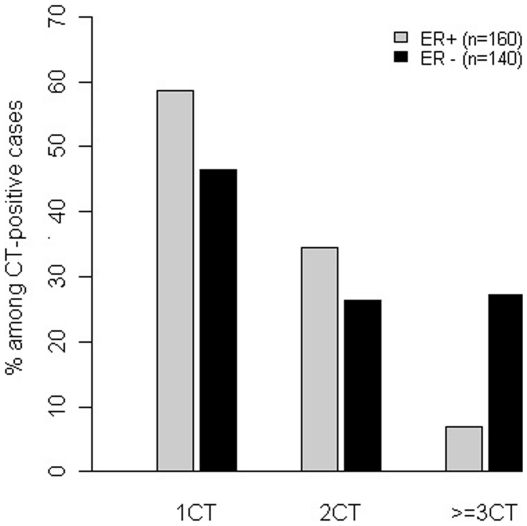
Distribution of cases expressing one, two or multiple CT antigens among all CT–positive cases in percentage.Significantly greater proportion of ER negative tumors expressed ≥3 antigens when compared to ER+ tumors (P = 0.026).